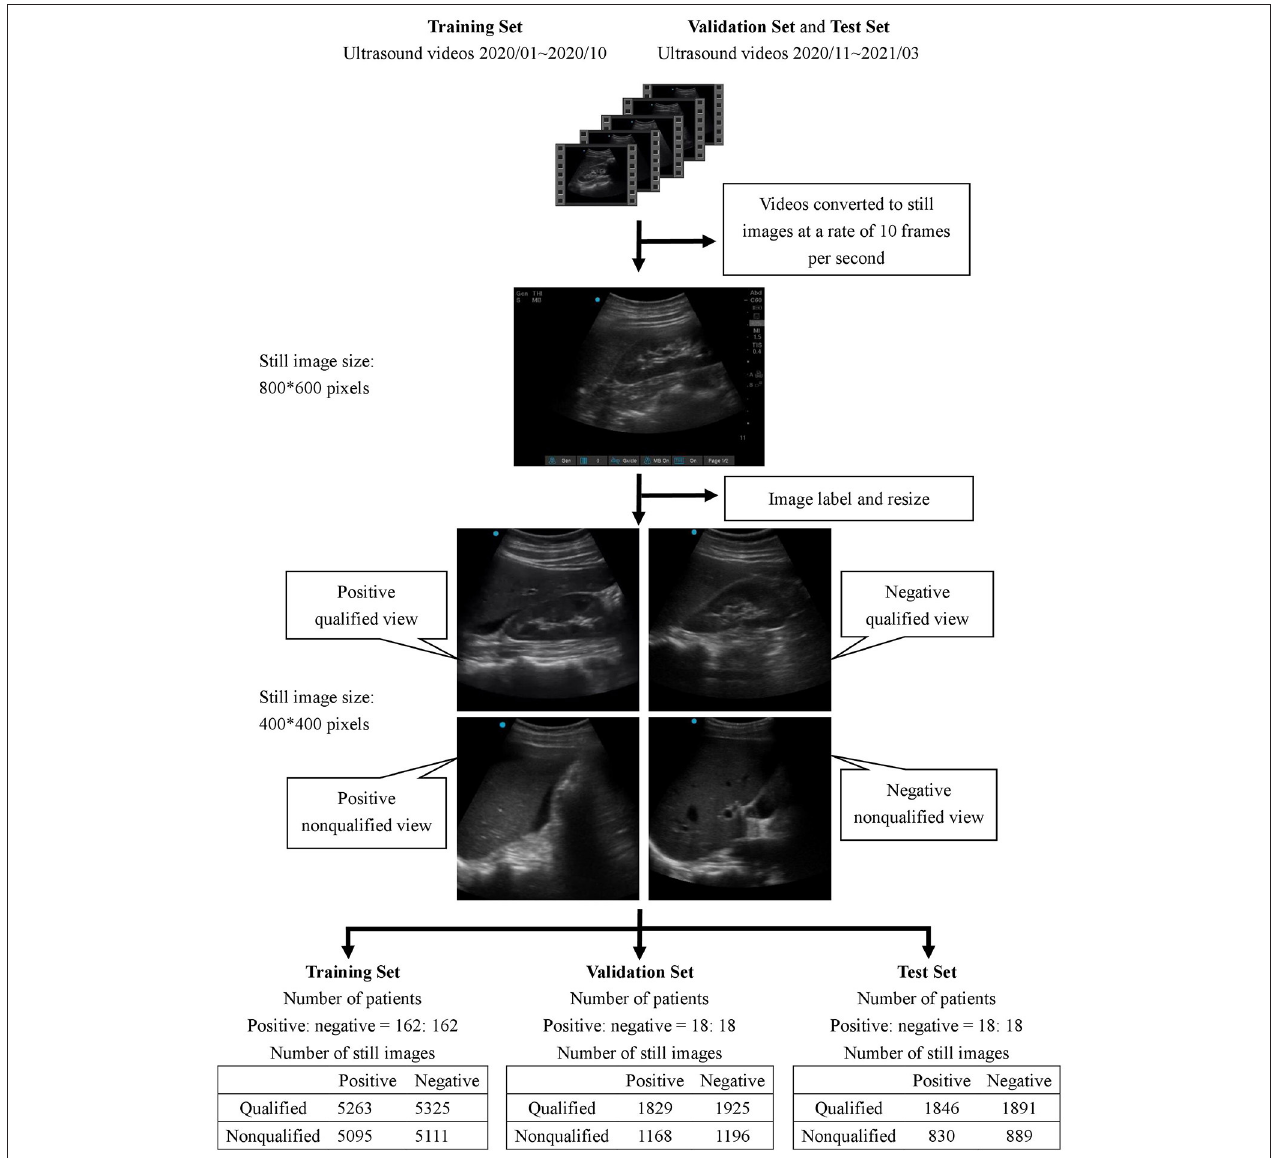
FIGURE 1 | Flowchart of dataset